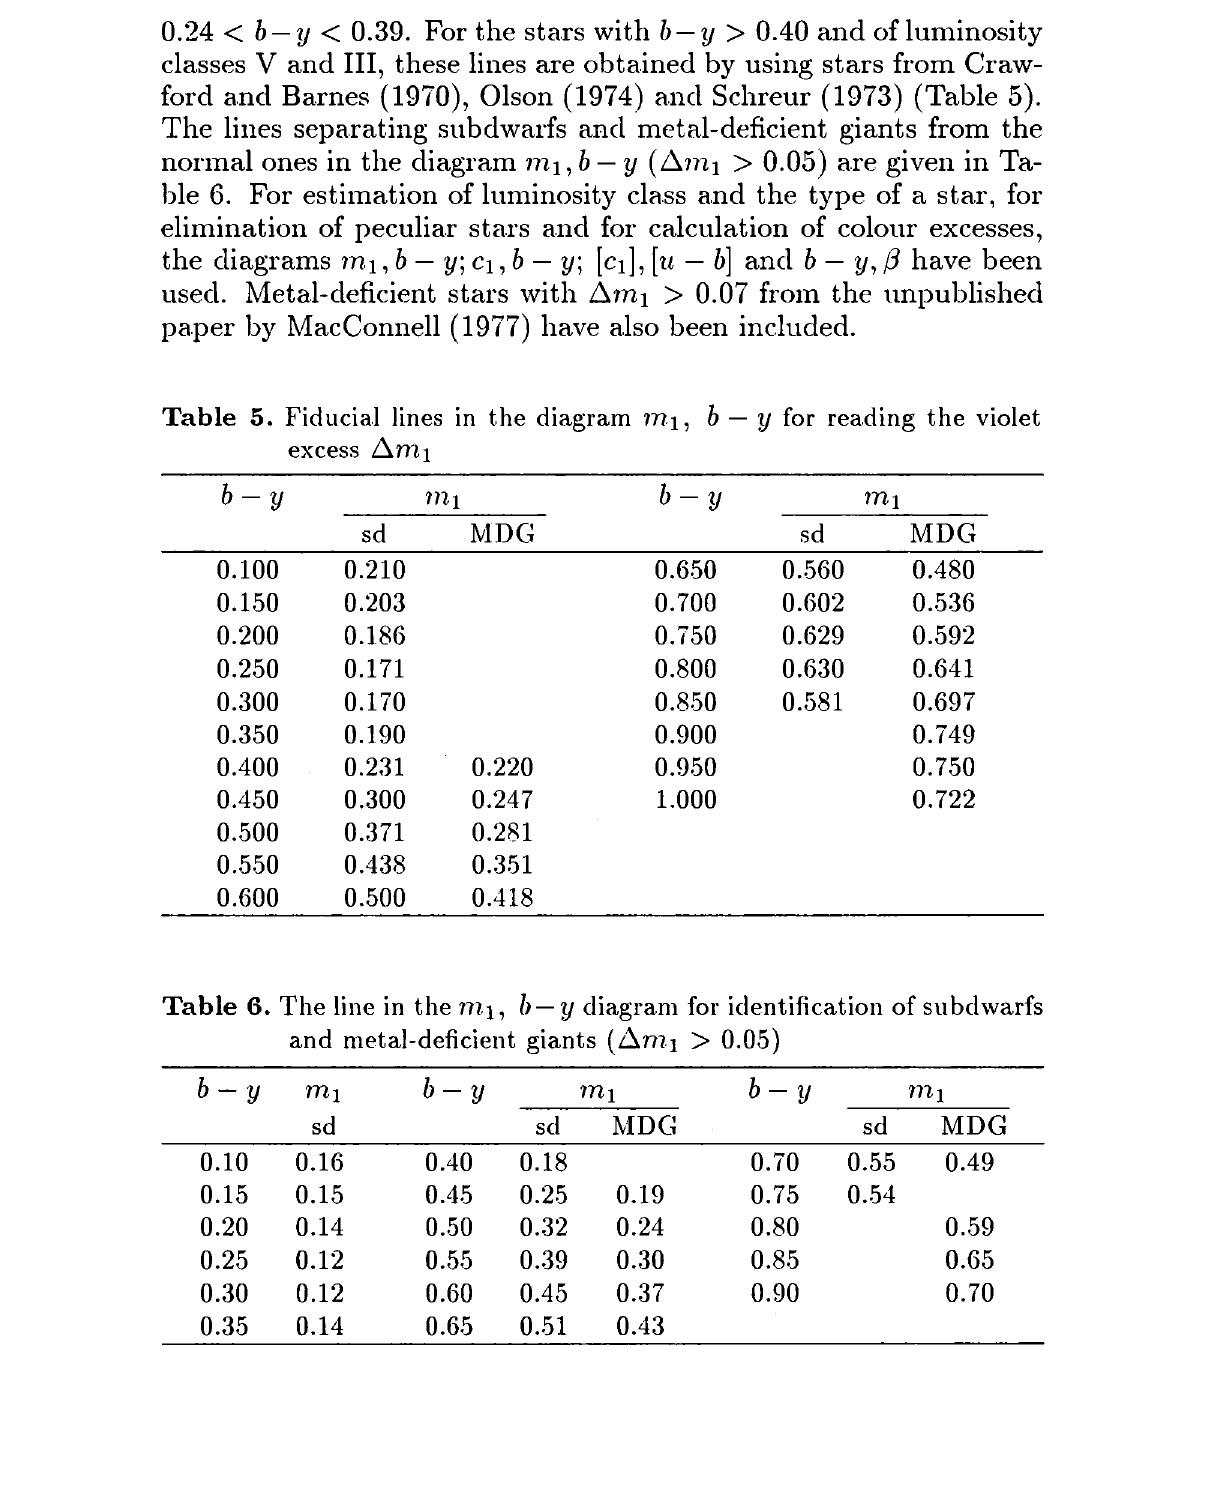
Table 5. Fiducial lines in the diagram mi, b — y for reading the violet